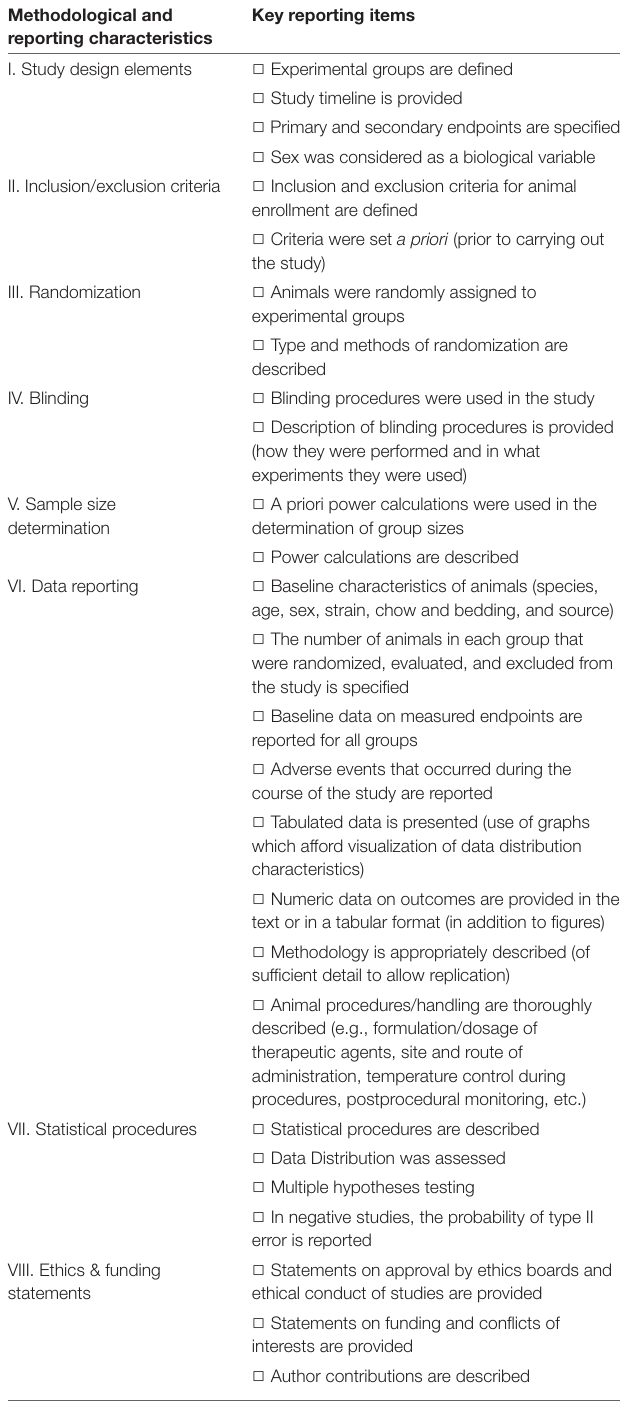
TABLE 2 | Experimental interventions in animals ( in vivo